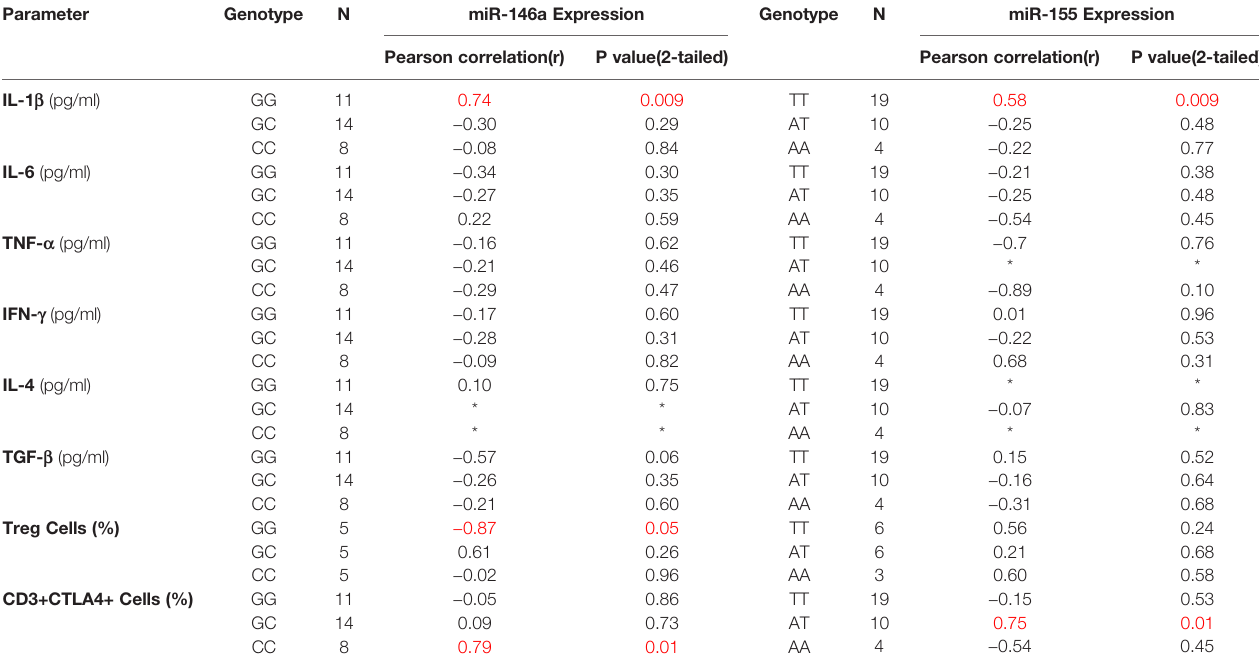
TABLE 9 | Correlation between miR-146a and miR-155 expression with the level of cytokines, Treg, and CD3+CTLA-4+ cells in patients based on genotypes.